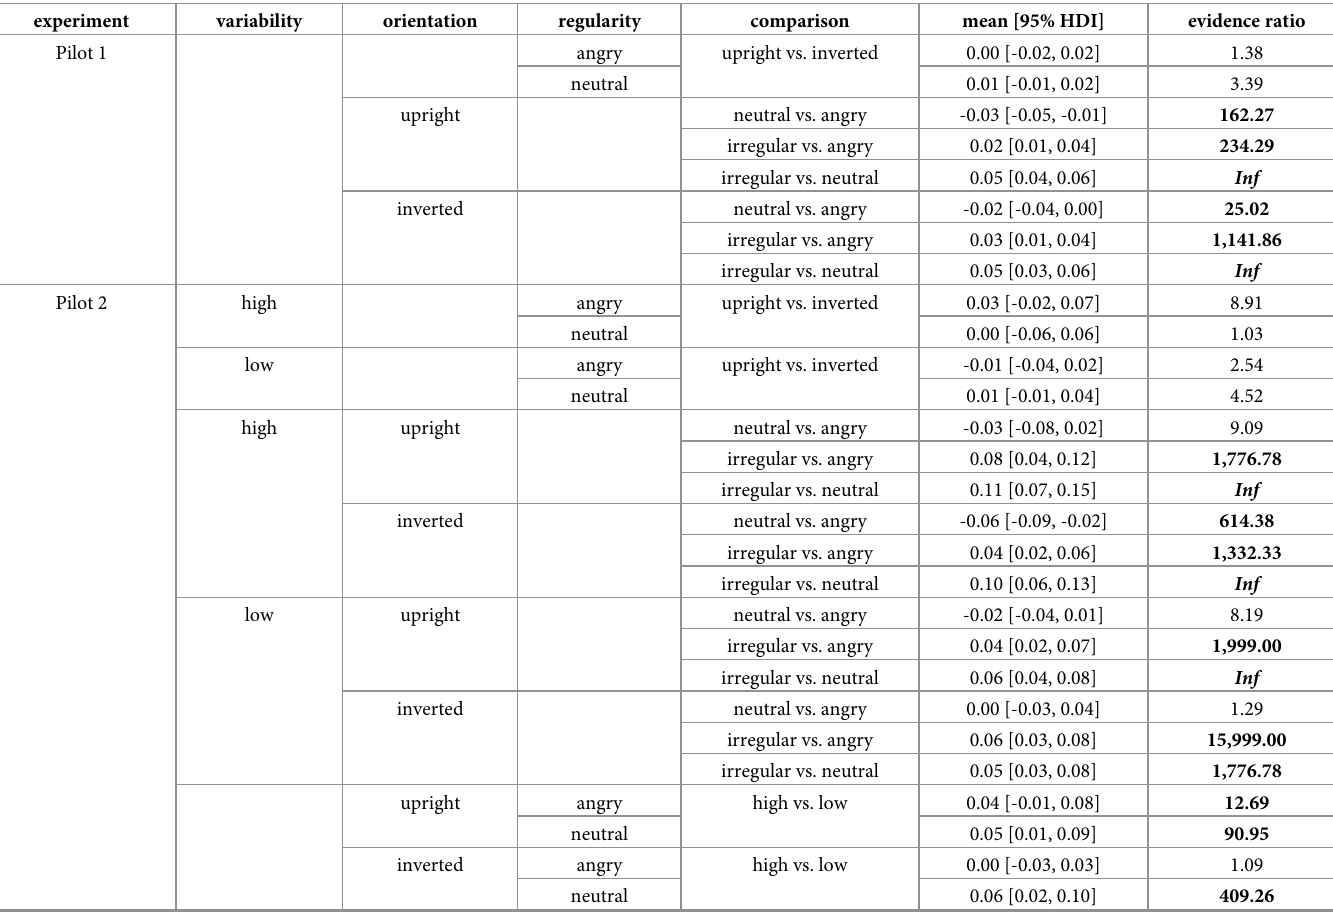
Table 3. Results statistical analyses Cosine Similarity Index (CS) at regularity frequency.